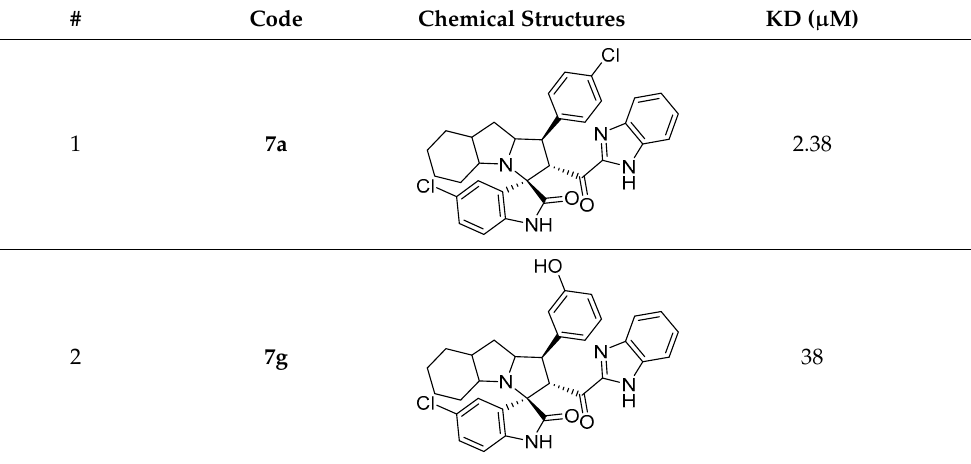
Table 2. MST binding assay results of MDM2.